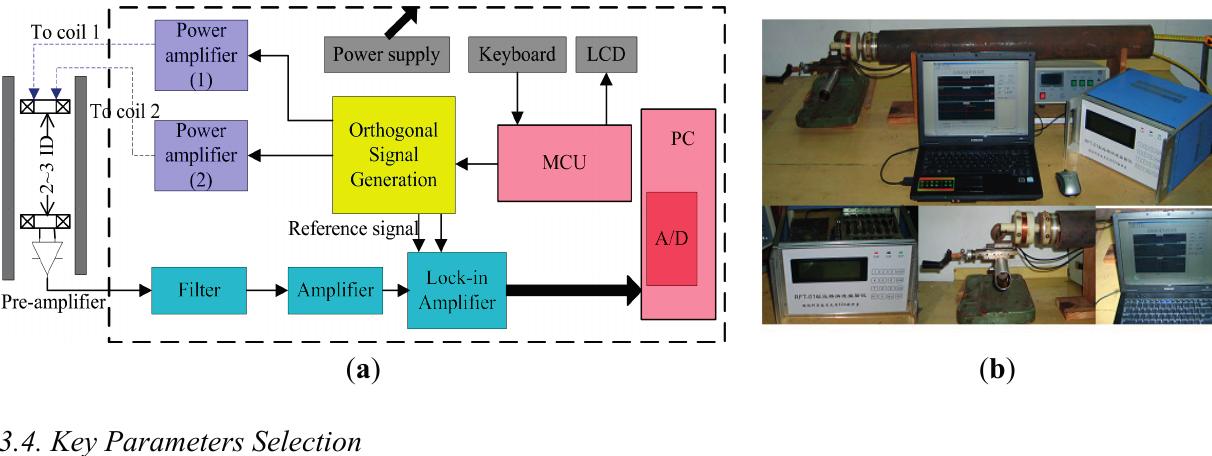
Figure 13. ( a ) Schematic diagram of experimental system; ( b ) Photograph of experimental system.